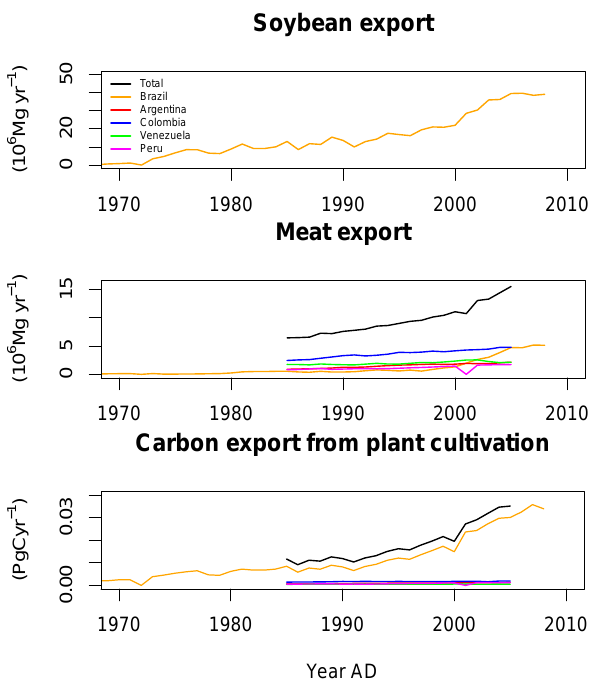
Fig. 5. Exports of agricultural products from five main South American agricultural exporters according to FAO statistics (http: //faostat.fao.org).